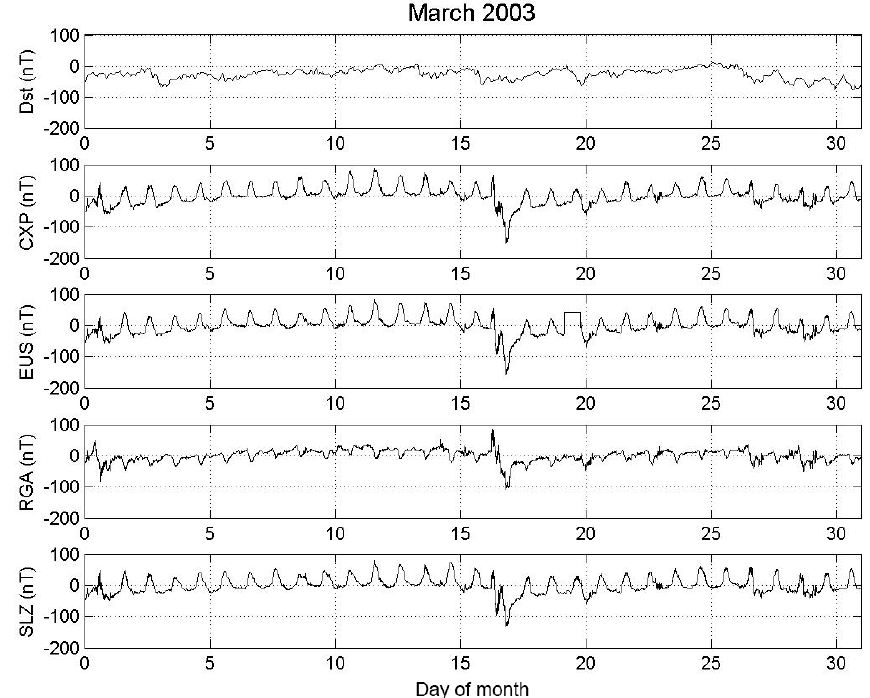
Figure 2. Plots of the Dst, CXP, EUS, RGA, and SLZ time series.